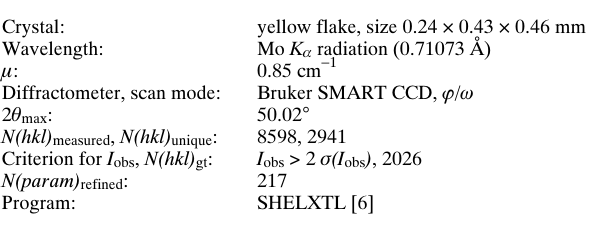
0.025(3)°), the dihedral angle between the two rings is 11.4(5)°.